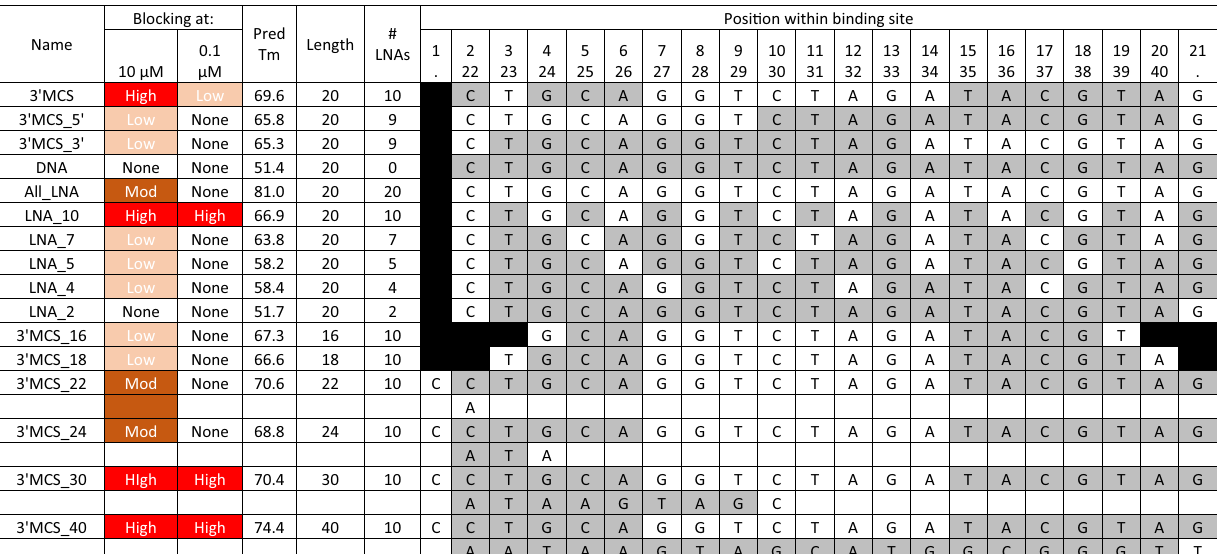
Table 1. Qualitative assessment of LNA/DNA blocking efficiency. Positions with LNAs are in white, positions with DNAs are in gray, and positions with no nucleotides are blacked out. Using a plasmid as the target DNA, different LNA/DNA chimera concentrations were added to the PCR mix at either 0.1 µM or 10 µM, and the product was analyzed via quantitative capillary electrophoresis. Blocking was assessed visually to determine relative efficiency. T m s were calculated using default conditions at https:// www. idtdna. com/ calc/ analy